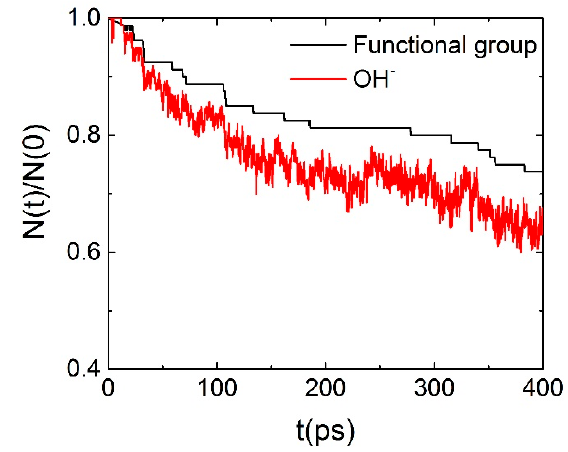
Figure 7. Time dependence of residual ratios for functional cationic groups and OH − .